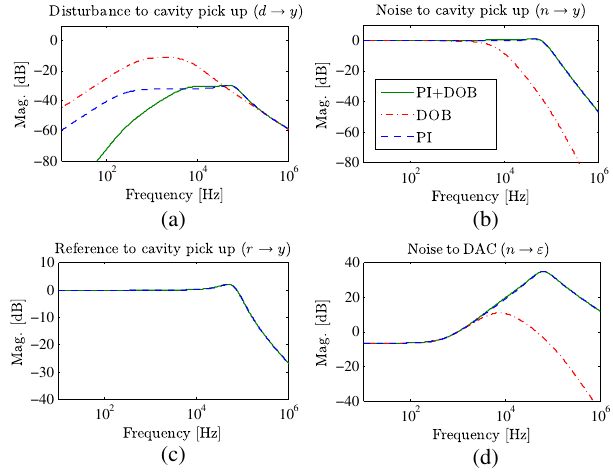
FIG. 7. Comparison of the closed-loop system response of the three controls (assuming δω ¼ 0 and δθ ¼ 0 ). Here, we select Q 02 ð s Þ with 5 kHz bandwidth as the Q filter (see Table III).